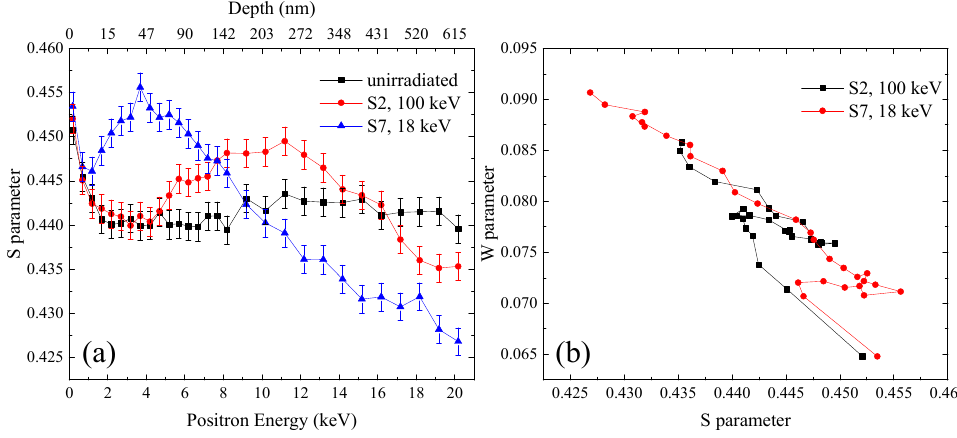
Figure 8. ( a ) S–E curves and ( b ) S–W curves for RAFM steels irradiated to the fluence of 1 × 10 20 m − 2 with 18 keV ‐ He + and 100 keV ‐ He + .